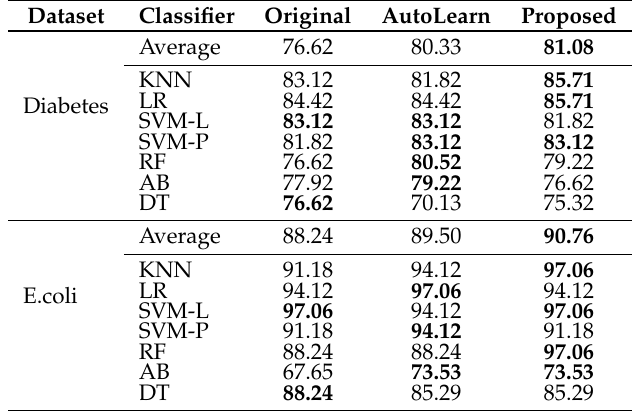
Table 7. Performance comparison in terms of classification accuracy